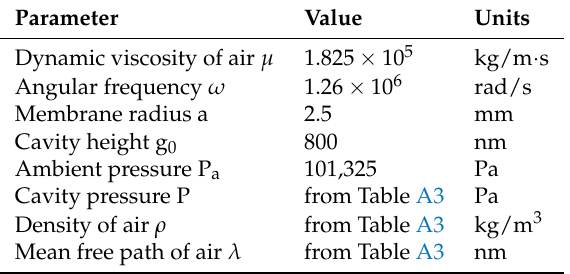
Table A2. Squeeze-number computation